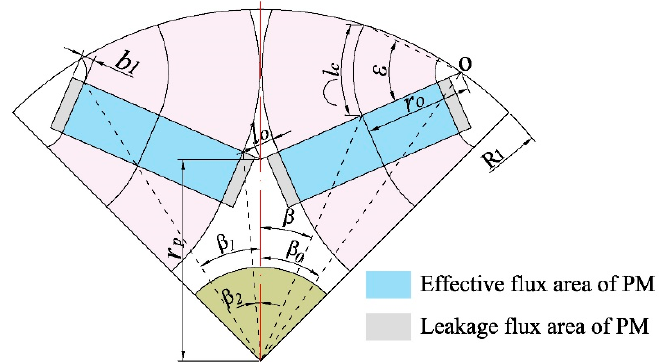
Figure 2. The calculation schematic diagram of V-shaped PM subdomain.